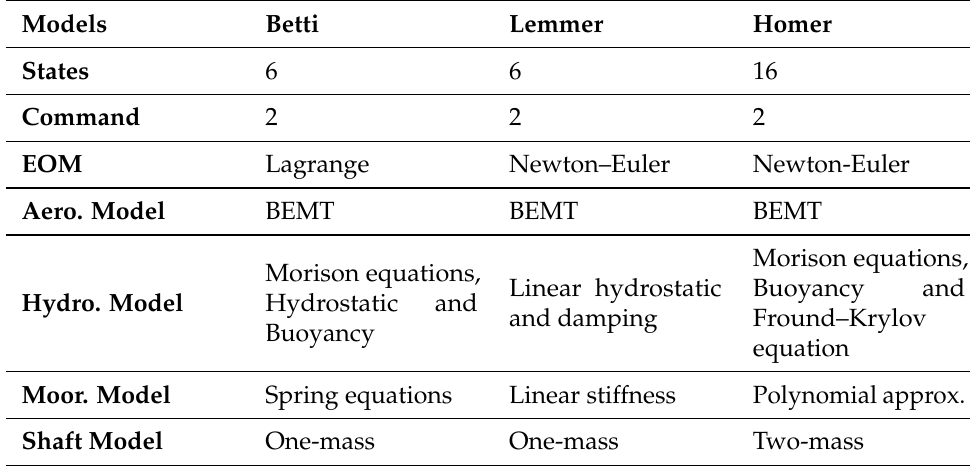
Table 1. Model blocks comparison of the three